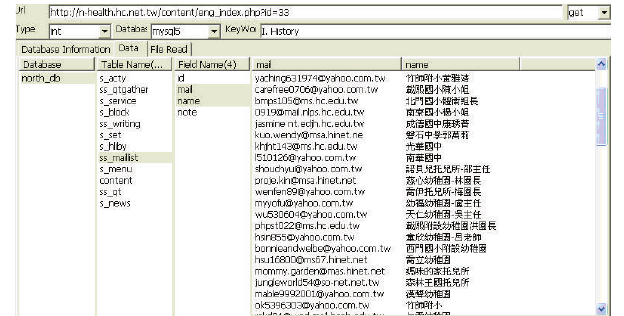
Figure 8: E-mail address leak in the database.